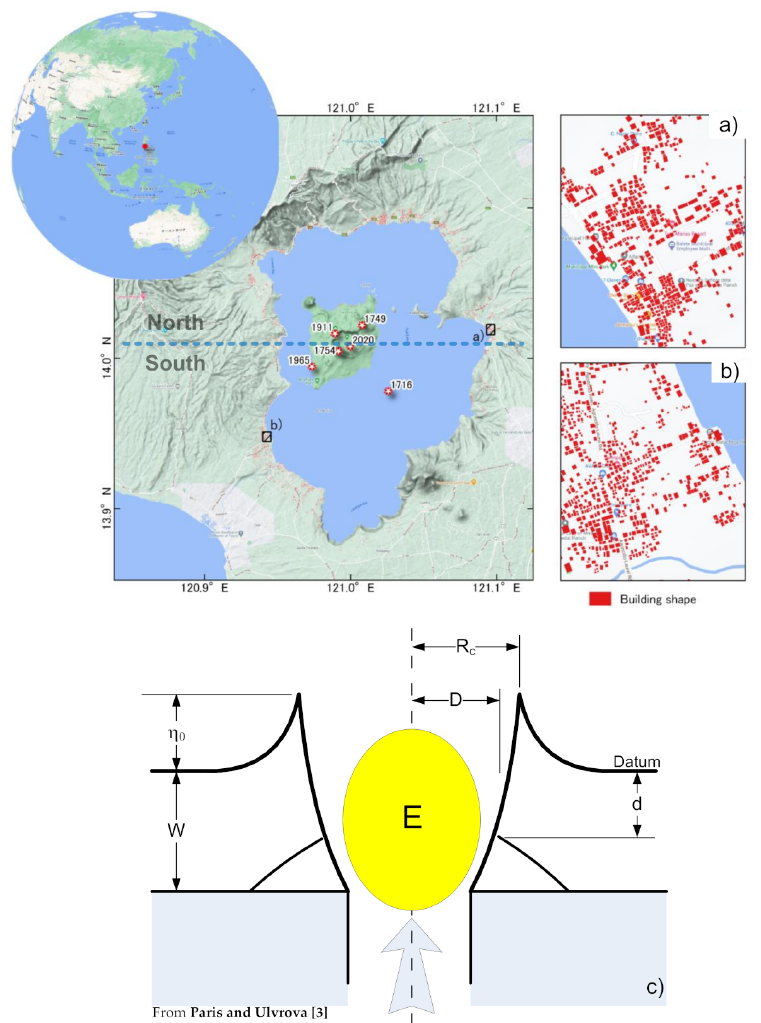
Figure 1. Location of Taal Lake and the history of eruptions in the lake; the blue dashed line is assumed to be the border between the north area and south area of the lake. ( a ) Example location of buildings in the eastern region and ( b ) example location of buildings in the western region. ( c ) Mechanism of initial water displacement from subaqueous volcanic explosion, E : explosion energy; d : explosion depth; D : diameter of vent area; R c : diameter of water cavity; W : total water depth around the volcano; η 0 : initial water surface